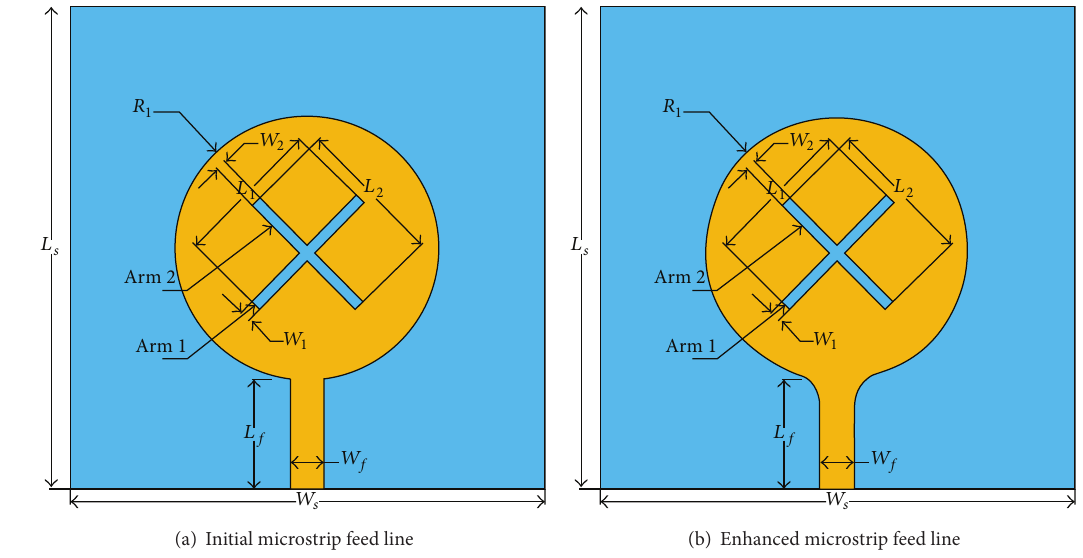
Figure 4: New dual-band design with microstrip feed line.